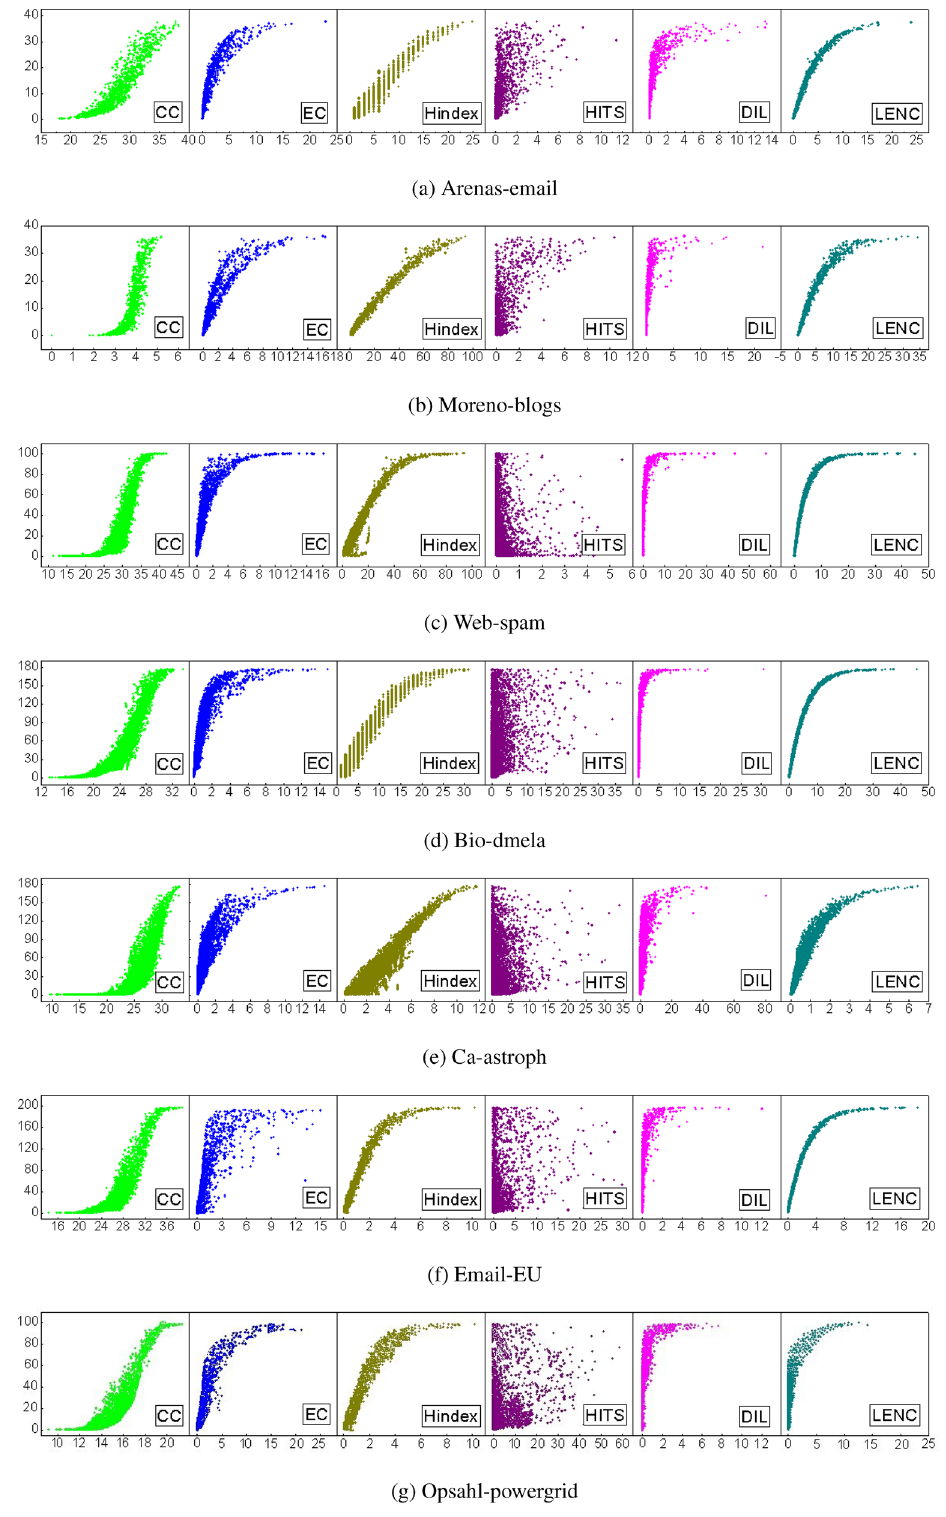
Figure 5. Correlation between significance evaluation indicator of different algorithms and SIR model